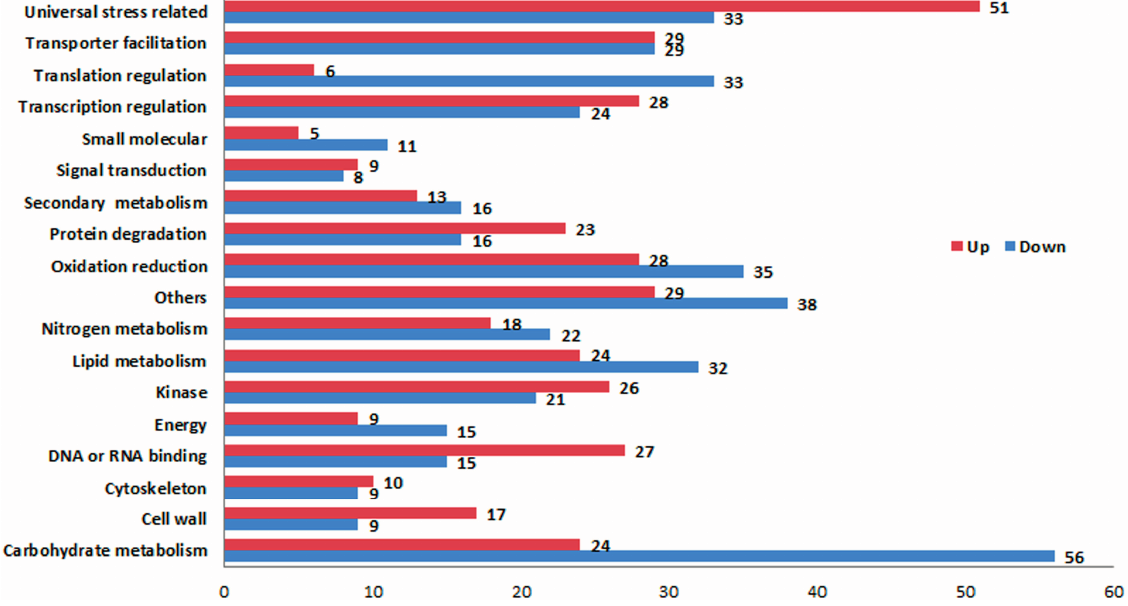
Figure 3. Comparison between up-regulated and down-regulated genes based on functional